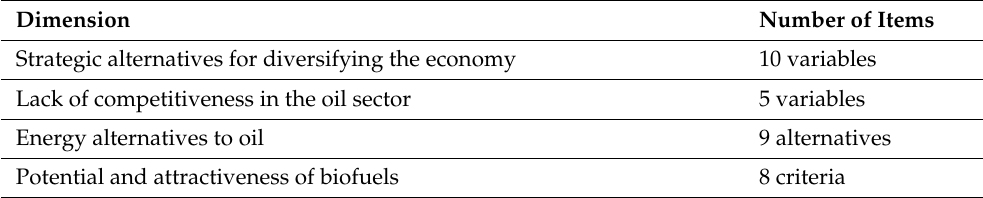
Table 2. Cont. Dimension Strategic alternatives for diversifying the